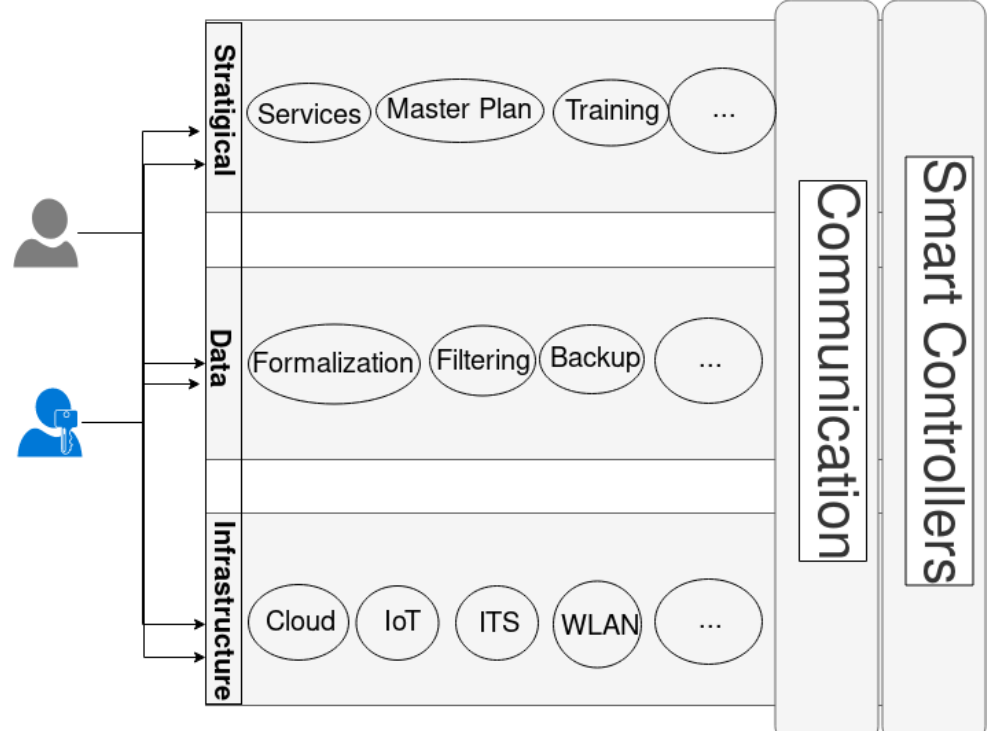
Figure 2. General framework of a smart